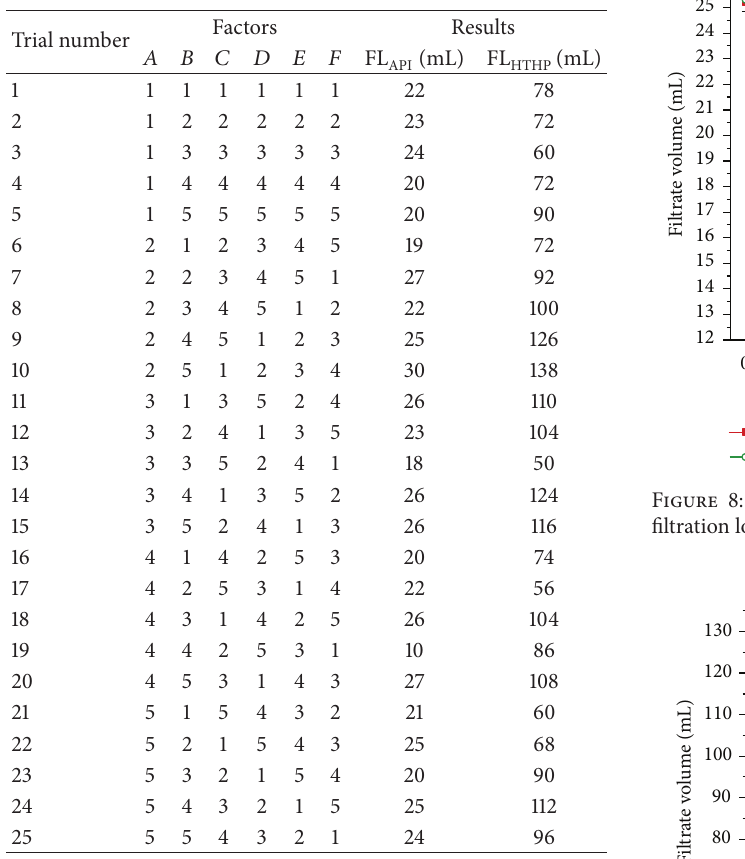
and FL in OA25 matrix. API HTHP